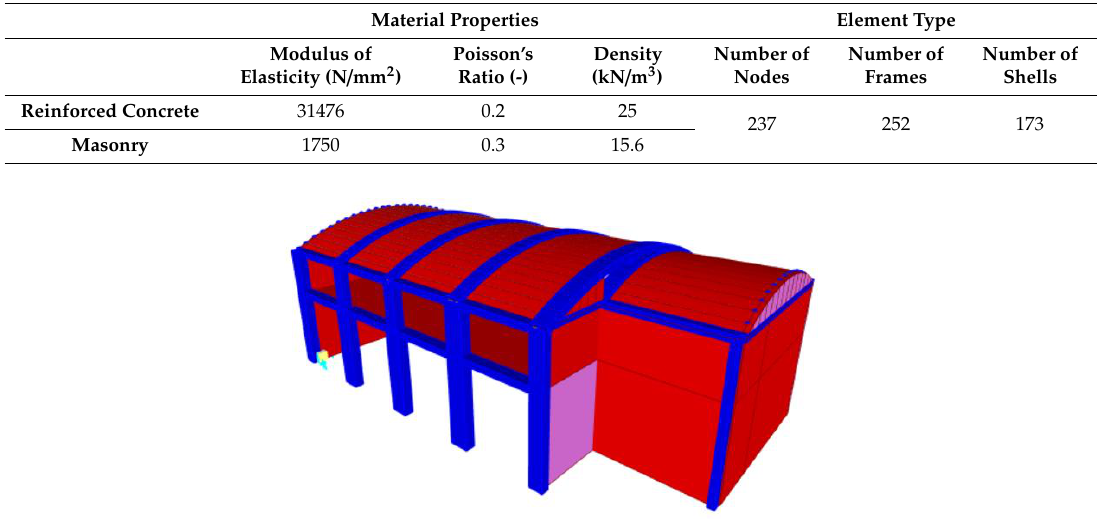
Figure 18. Three-dimensional (3D) Finite Element Model of the Structure A.